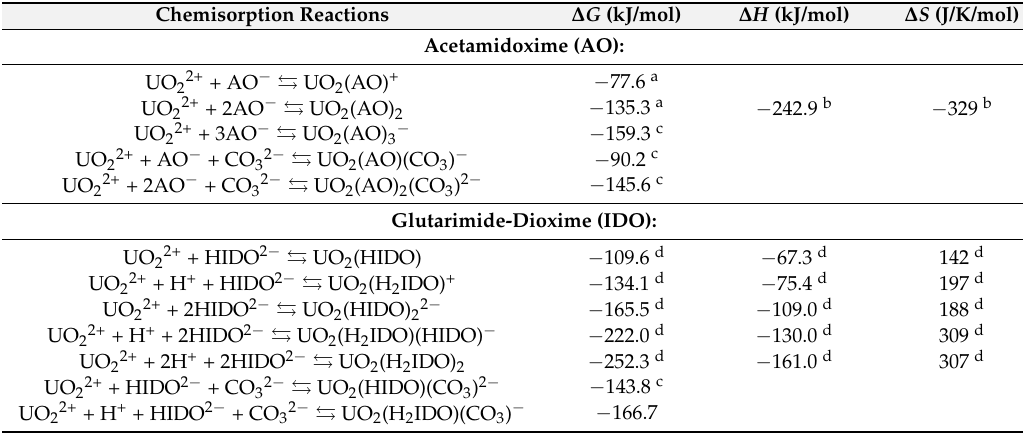
Table 3. Summary of uranyl/ligand reactions considered by the chemisorption model. All ∆ G values are given at 25 ◦ C.